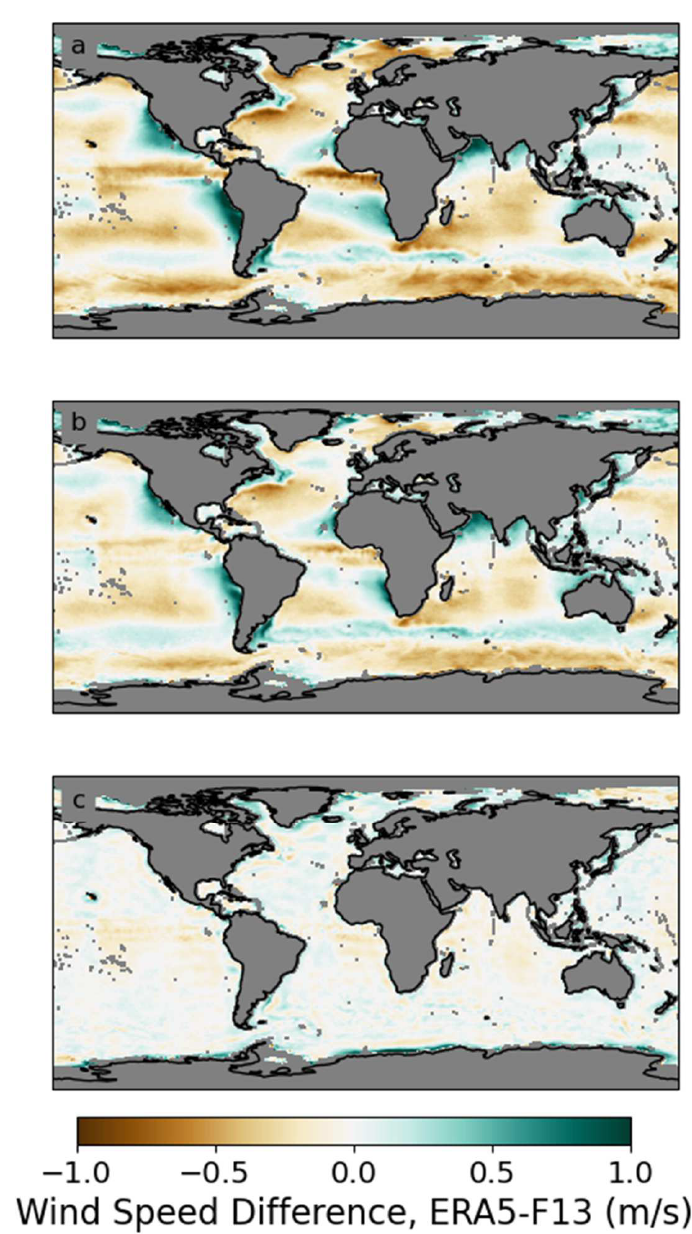
Figure 8. Global maps of the differences between ERA5 and SSM/I F13, averaged over 1996–2009. ( a ) shows the differences relative to ERA5_OSCAR. There are large regional biases, with several areas showing average differences as large as 1 m/s. ( b ) shows the differences relative to ERA5_ADJ. The adjustments applied to ERA5 reduced the ERA5-F13 differences, but substantial regional differences remain. After regional wind speed adjustments were applied to the F13 winds, the differences are much reduced (panel c ). We note that the corrections applied to F13 was derived using all Rad_MED instruments (F10, F11, F13, F14, F15, F16, F17 and F18). The success of these adjustment for F13 indicates that the differences are consistent across instruments of the same